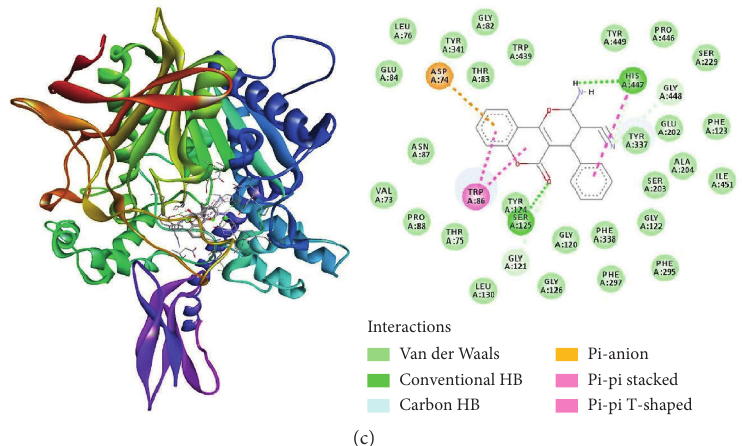
Figure 13: Best poses of the Chrom-D ligand in selected AChE enzymes along with ligand/enzyme interactions in 2D diagrams. (a) 1B41-